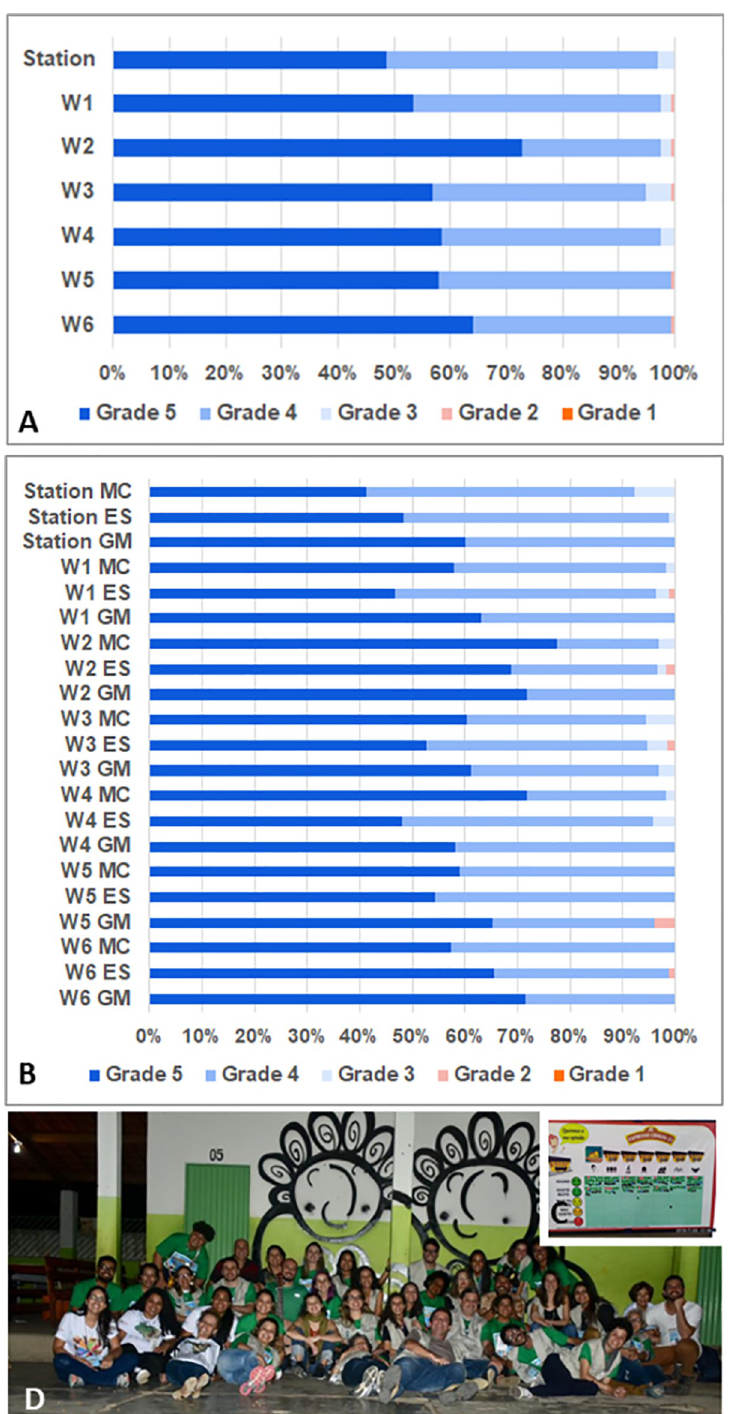
Fig 5. Chagas Express public evaluation and mural painting legacy : (A) Global evaluation of each space of the exposition expressed as the percentage of stickers inserted in each wagon frame. “Station” corresponds to entry/exit module and “W1” to “W6” corresponds to wagon 1 to wagon 6. Only the participants attending the activity of wagon 6 participated in the evaluation study and the total number (n) of bullets (100%) were of 171 in the Station Lassance, 163 for wagon 1, 155 for wagon 2, 158 for wagon 3, 164 for wagon 4, 133 for wagon 5 and 186 for wagon 6. Grade/Points were expressed as emoticons: Grade 5 = I love it; Grade 4 = I liked it very much; Grade 3 = I liked it more or less; Grade 2 = I didn´t like it; Grade 1 = I hated it. (B) Similar evaluation of Fig 5A, shows the specific data collected at